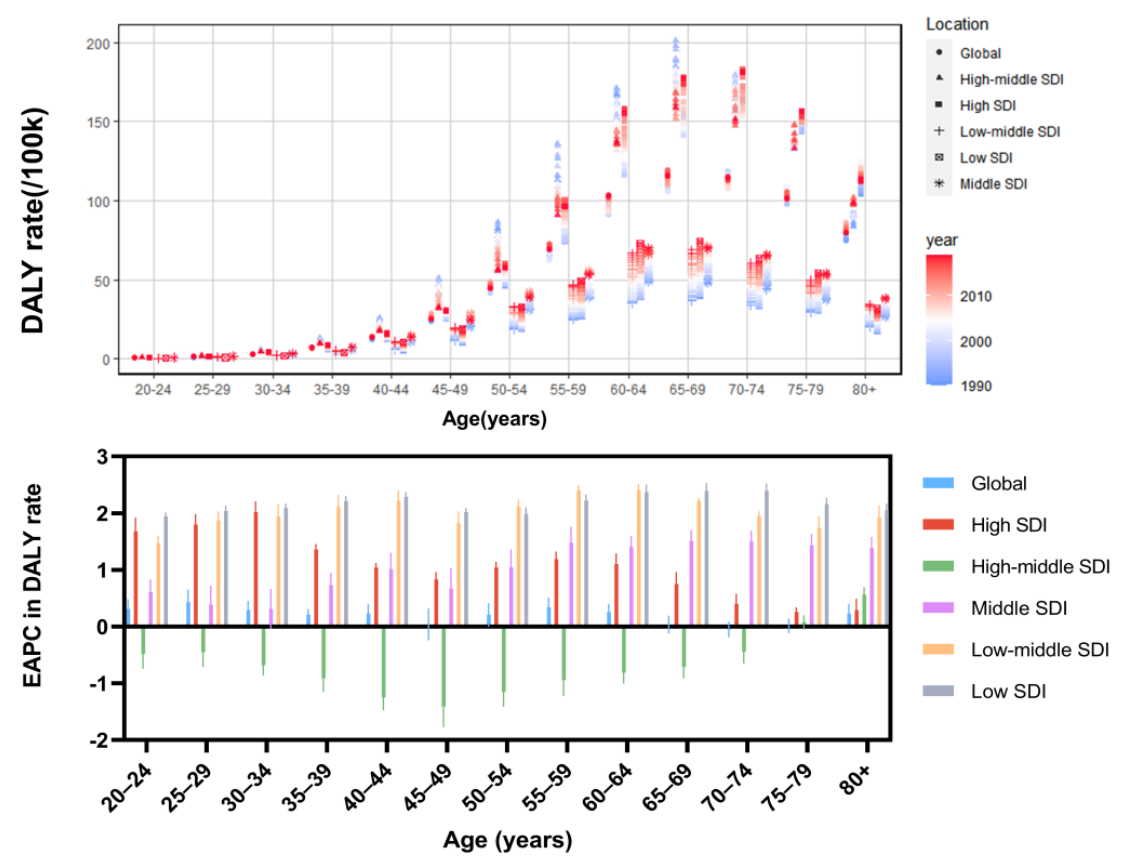
Figure 6. Mortality rate among different age groups in the global and SDI regions in 2019 and their EAPC between 1990 and 2019. SDI, Socio-demographic Index; EAPC, Estimated annual percentage change.